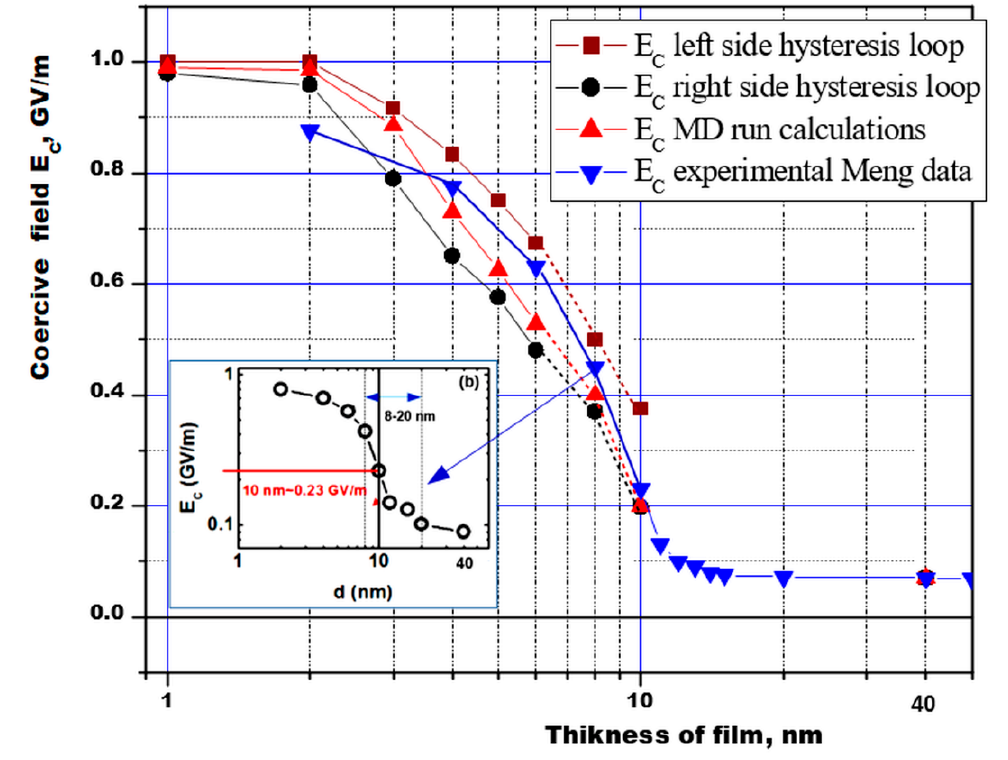
Figure 5. The dependence of the coercive field of the ferroelectric polymer PVDF on the film thickness, according to the results of calculations by different methods (from hysteresis loops and MD runs) in comparison with experimental data [16] (inset (b) is from Figure 4), taking into account the dielectric constant of an ultrathin molecular film ε ≈ 2.4. (It is our new original recalculated data, which continues from our preliminary calculations and estimations [18,19,27,28]).